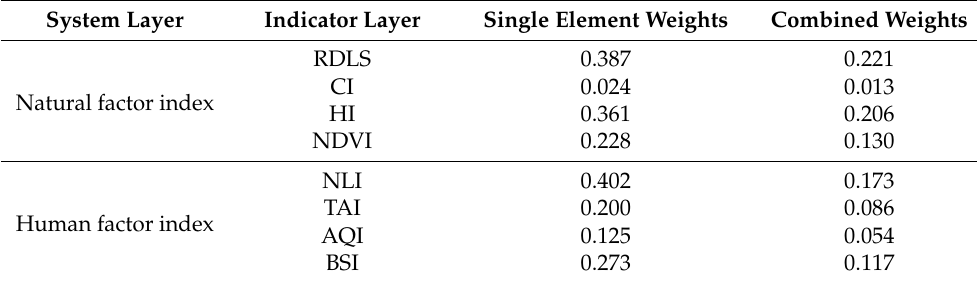
Table 2. Weight of each index of HSCSI in the YRD. System Layer Indicator